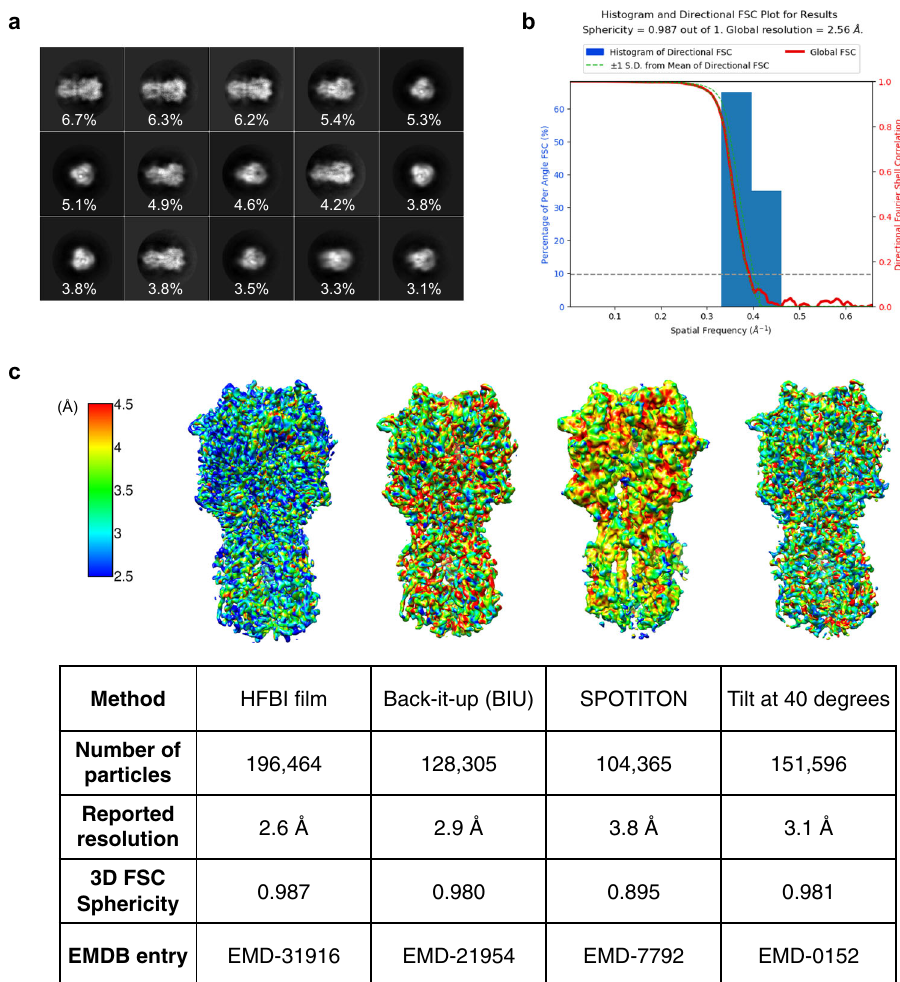
Fig. 4 Using HFBI fi lm to solve the preferred orientation problem of the in fl uenza HA trimer. a Representative 2D class averages of the in fl uenza HA trimer from the cryo-EM dataset collected using the HFBI fi lm-covered ANTA foil grid. Both side and top views can be captured. The percentage of the number of particles in each class is labelled accordingly. b 3D-FSC plot of the cryo-EM reconstruction of in fl uenza HA trimer using the HFBI fi lm covered ANTA foil grid. c Comparisons of in fl uenza HA trimer cryo-EM maps solved using different sample preparation approaches. “ Tilt 40 degrees ” , the specimen was vitri fi ed using a normal Quantifol Au grid, and the grid was tilted to 40° during data collection to solve the preferred orientation 62,64 . “ SPOTITON ” , the specimen was fast vitri fi ed using a self-wicked grid and Spotiton device 33 . “ Back-it-up (BIU) ” , the specimen was rapidly vitri fi ed by combining ultrasonic application and a through-grid wicking approach using a glass fi bre fi lter 63 . “ HBI- fi lm ” , the specimen was vitri fi ed using the HFBI fi lm covered ANTA foil grid (this work). The cryo-EM maps of the in fl uenza HA trimer are coloured according to their local resolutions (from 4.5 Å in red to 2.5 Å in blue), which were estimated using DeepRes 88 . The number of particles used for the fi nal reconstructions, reported resolution, 3D-FSC sphericity and the corresponding data entry (EMDB) are shown for each